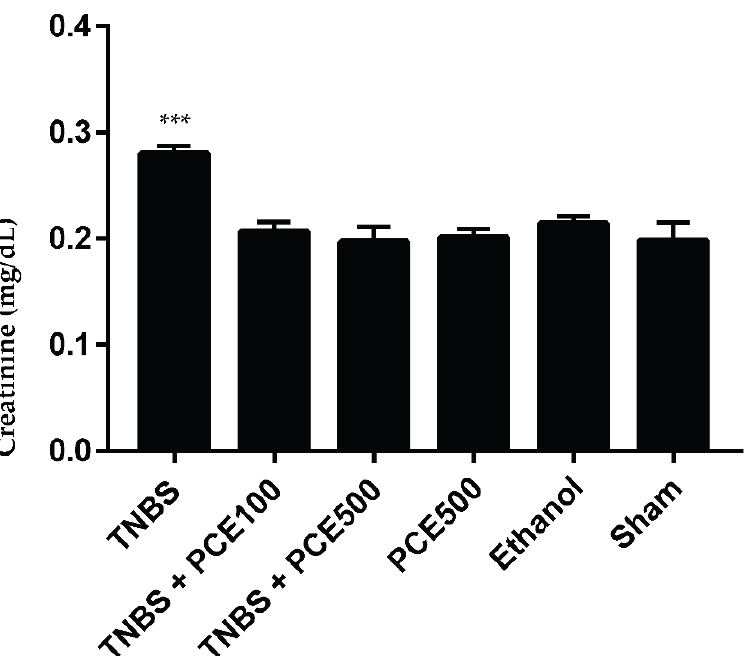
Figure 6. Effect of PCE treatment on creatinine concentration in the IBD. The results are represented as mean ± SD [ n (TNBS + PCE100) = 10; n (TNBS + PCE500) = 10; n (PCE) = 10; n (TNBS) = 6; n (Ethanol) = 5; n (Sham) = 5; *** p < 0.001; compared with sham group, one ‐ way ANOVA followed by Tukey’s post hoc test]. Abbreviations: IBD, inflammatory bowel disease; PCE, phenolic compounds extract; TNBS, 2,4,6 ‐ Trinitrobenzene sulfonic acid.